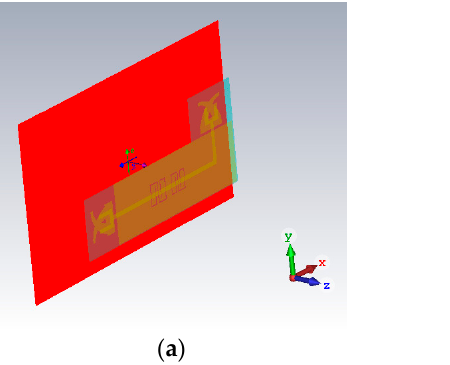
Figure 7. Numerical results achieved for a 2-bit overall system tag: ( a ) setup used during full-wave simulations; ( b ) numerical results achieved for the RCS of the device reported in Figure 7a.